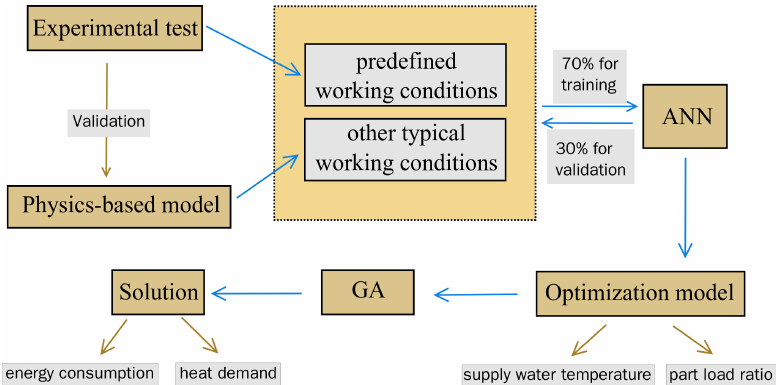
Figure 1. Flowchart of the proposed optimization methodology.